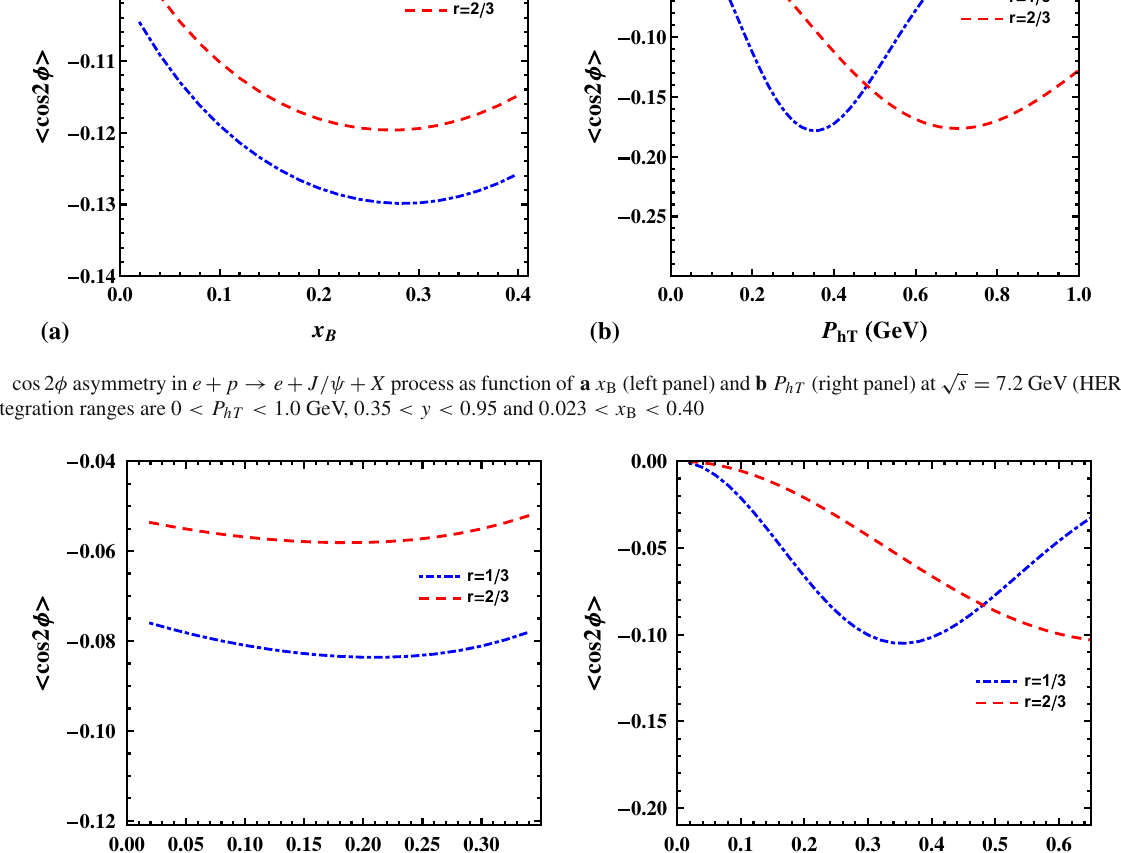
Fig. 10 cos2 φ asymmetry in e + p → e + J /ψ + X process as function of a x B (left panel) and b P hT (right panel) at The integration ranges are 0 < P hT < 0 . 64 GeV, 0 . 7 < y < 0 . 9 and 0 . 0001 < x B < 0 .